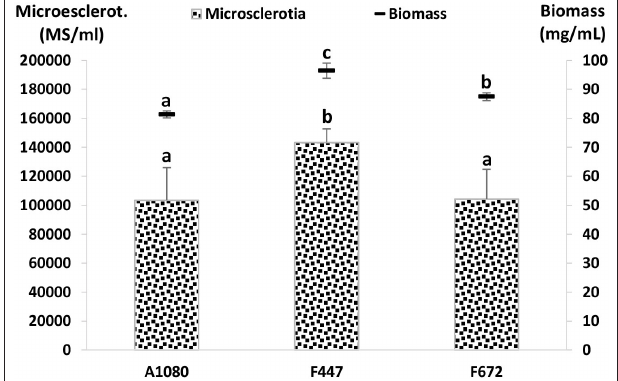
FIGURE 3 | Biomass and MS production by entomopathogenic fungi in basal salts solution with trace metals and vitamins (C:N ratio 23:1). Biomass (mg/mL); LSD 5 % = 4.9, p < 0.01. Microsclerotia (MS/mL); LSD 5 % = 32,542.3, p < 0.05. Error bars = standard error.